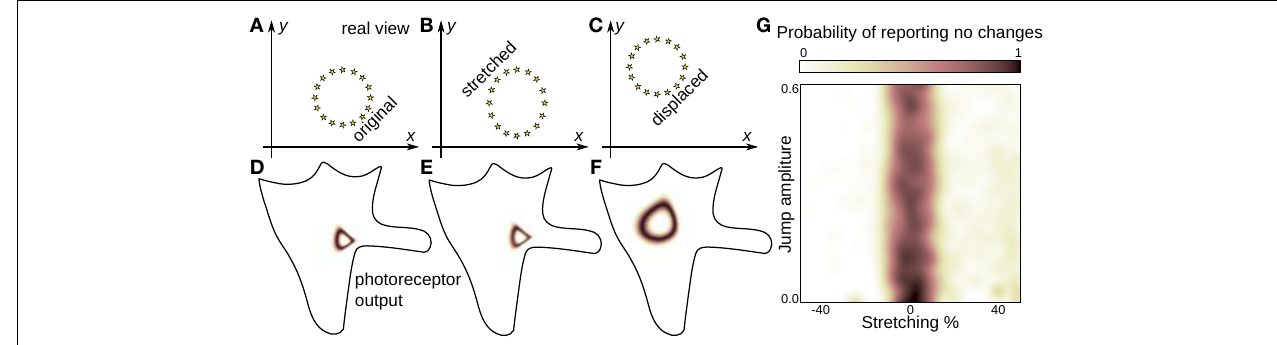
FIGURE 4 | The notion of space as unchanging medium . The 2D agent can distinguish between the sensory changes provoked by its own movement and those resulting from the joint effect of its own motion and changes in the environment. The agent is presented with an environment (A) which it scans (D) . Then the agent makes a jump and simultaneously the environment is stretched or shrunk along one axis by a certain amount (B) , which can be zero (C) . The agent is to judge whether the environment was the same before and after the jump. Note that the visual input in the modified environment (E) resembles the original (D) more than it does the unchanged environment (F) . Yet, the agent can successfully identify the case when the environment does not change, and it can do this independently of the extent of the jumps (G) . This ability of the agent underlies the notion of space as an unchanging medium through which the agent makes displacements .